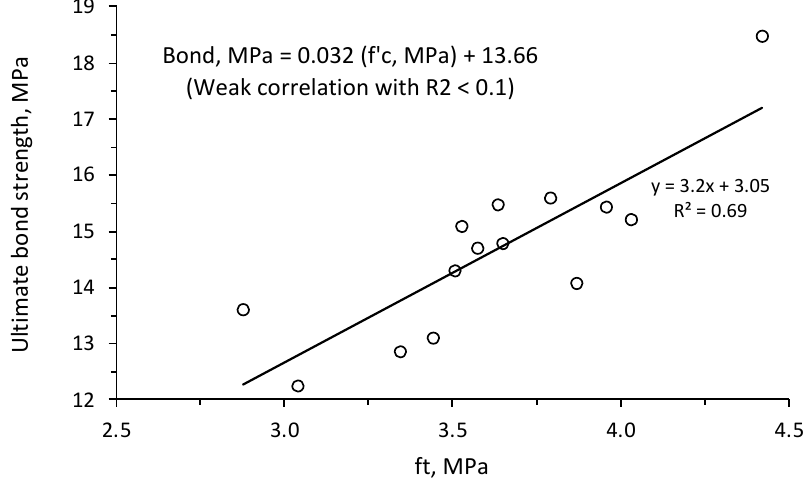
Figure 9. Effect of concrete modification on Δ ( τ (cid:2923)(cid:2911)(cid:2934) ) and Δ (Slip) for NCA and RCA concrete.